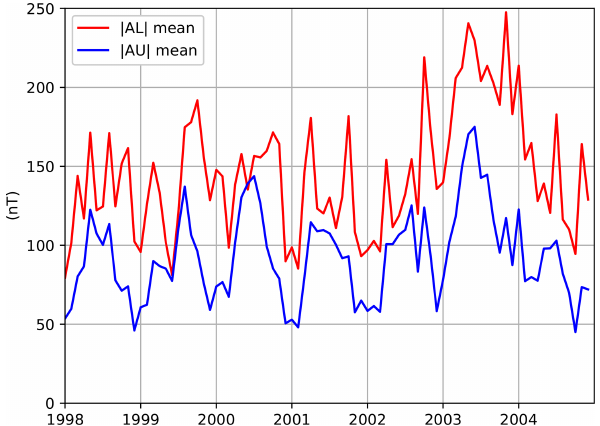
Figure 2. The mean | AU | and | AL | for each month from 1998 to